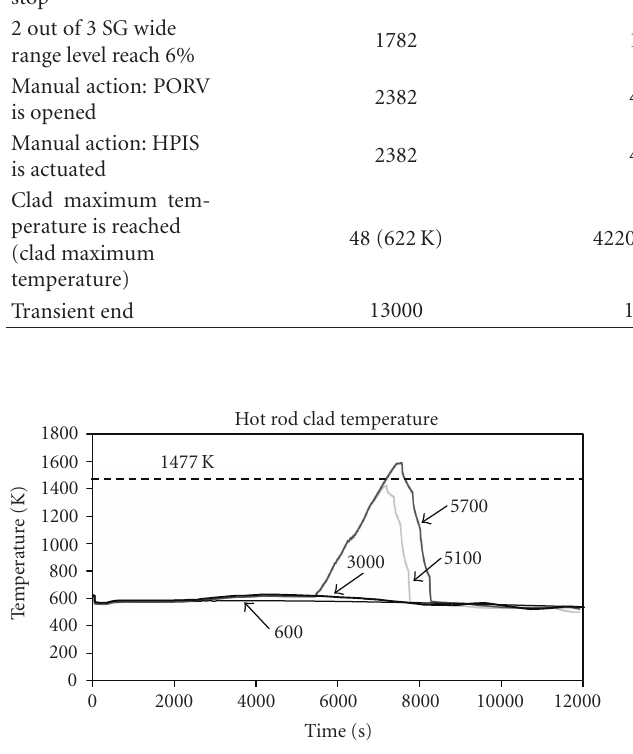
Figure 14: Hot rod clad temperature (F&B starting time analysis). Figure 15: Hot rod clad temperature (F&B heat sink recovery anal-